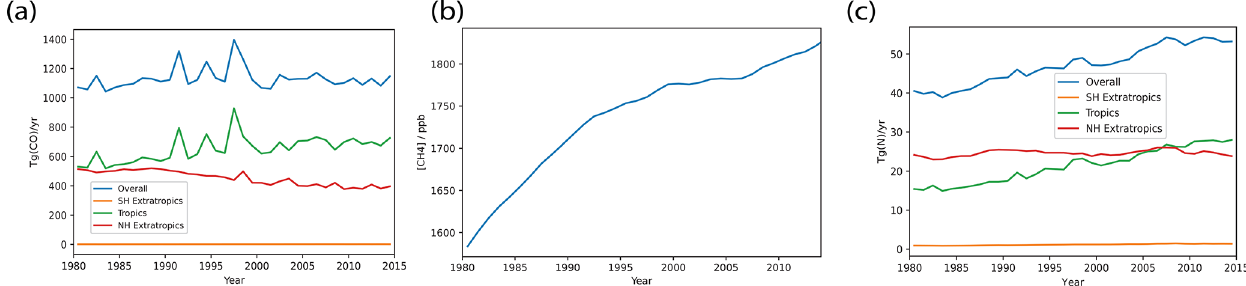
Figure 1. Historical time series of (a) regional CO emissions, (b) CH 4 surface concentrations and (c) regional NO x emissions used for this study. The Southern Hemisphere (SH) extratropics are defined as 90–30 ◦ S, the tropics are defined as 30 ◦ S–30 ◦ N, and the Northern Hemisphere (NH) extratropics are defined as 30–90 ◦ N. Globally, CH 4 concentrations have increased by ∼ 16%. Non-lightning NO x emis- sions have also increased by ∼ 30% globally over this period, with this increase driven by the tropics. CO emissions see IAV but little trend globally over this period, but they do see a decreasing trend in the NH extratropics offset by an increasing trend in the